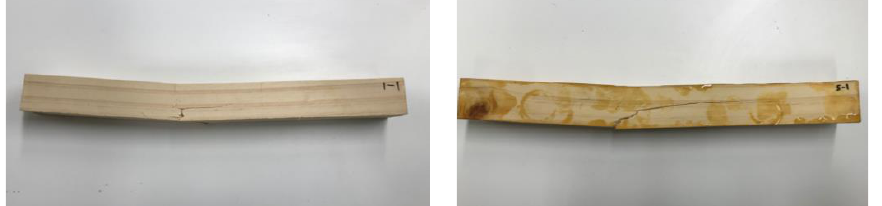
Figure 6. A 40 × 40 sample piece from benchmark case 1 ( left ) compared to the most promising reinforced 40 × 40 sample Case 5 ( right ) after loading.